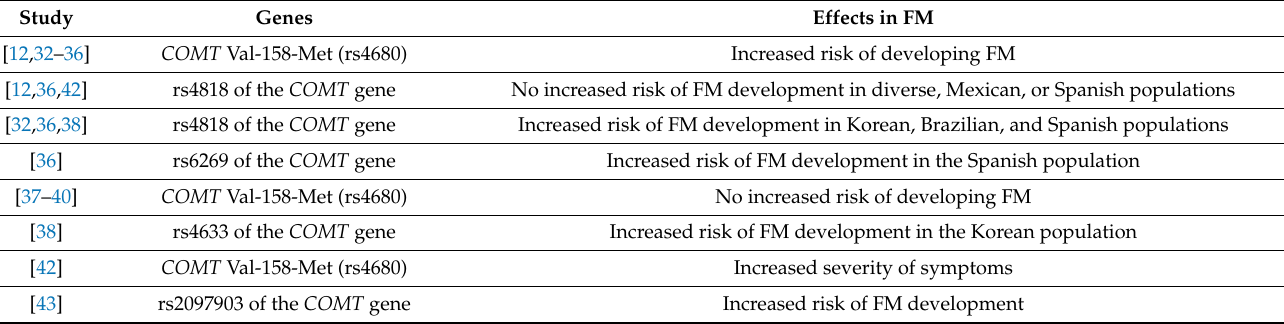
Table 1. Associations of COMT Polymorphisms and FM Development and